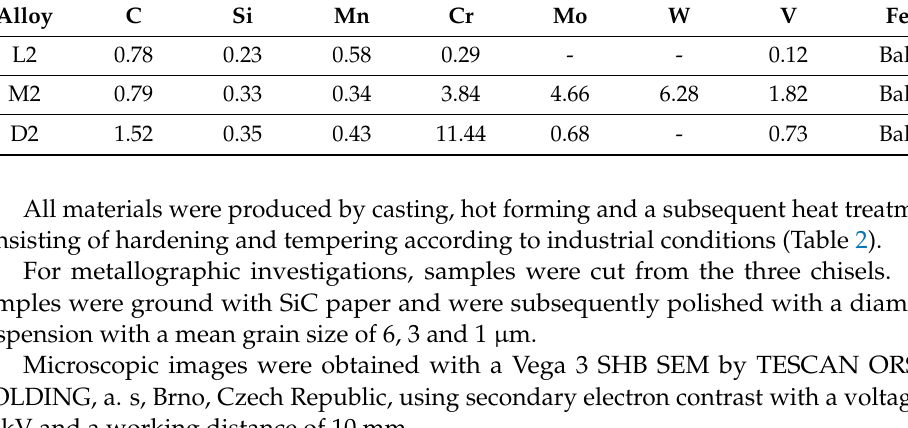
Table 1. Chemical composition of the investigated alloys.